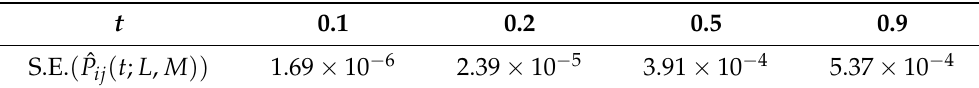
Table 8. Squared errors for the estimators of the semi-Markov transition probabilities in the case of censoring at the beginning and/or at the